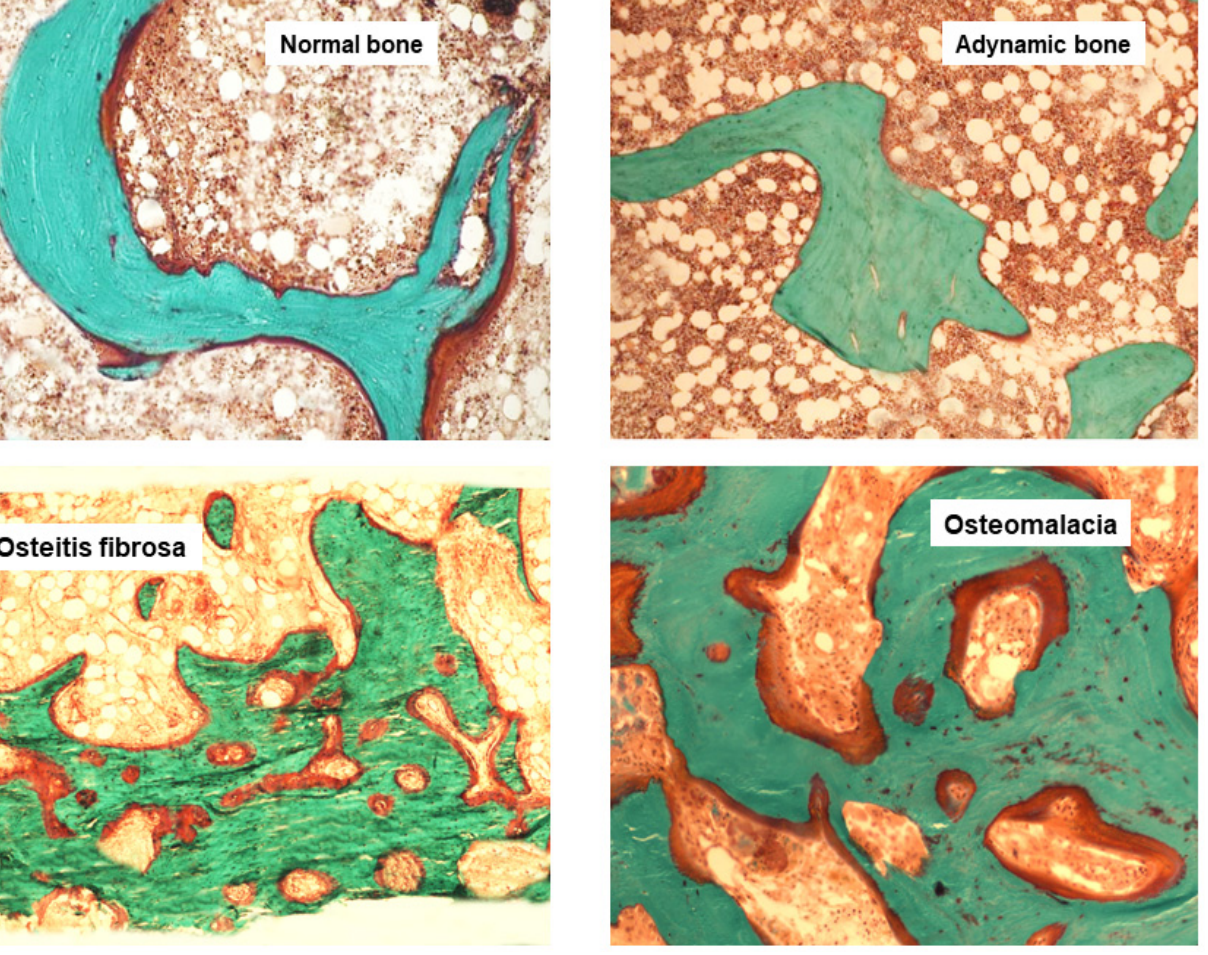
Figure 5. Goldner trichrome-stained bone section representing the main histomorphometric patterns of Renal Osteodystrophy ROD.